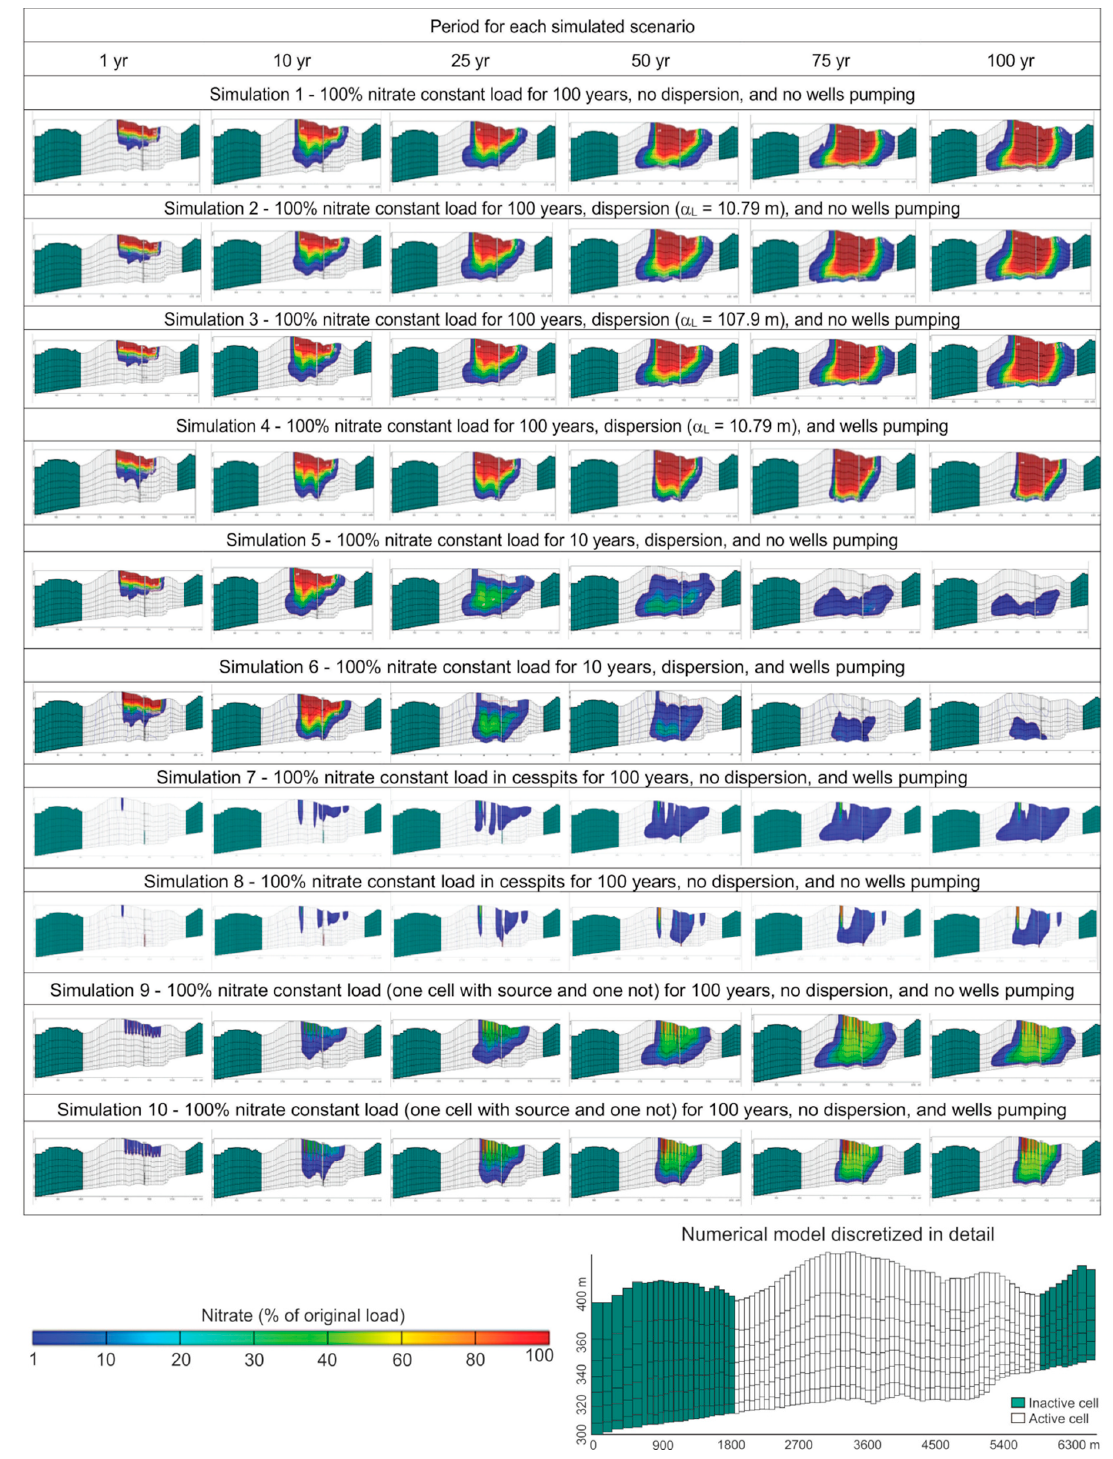
Figure 7. Simulated nitrate distribution scenarios in the Adamantina Aquifer in Urânia.